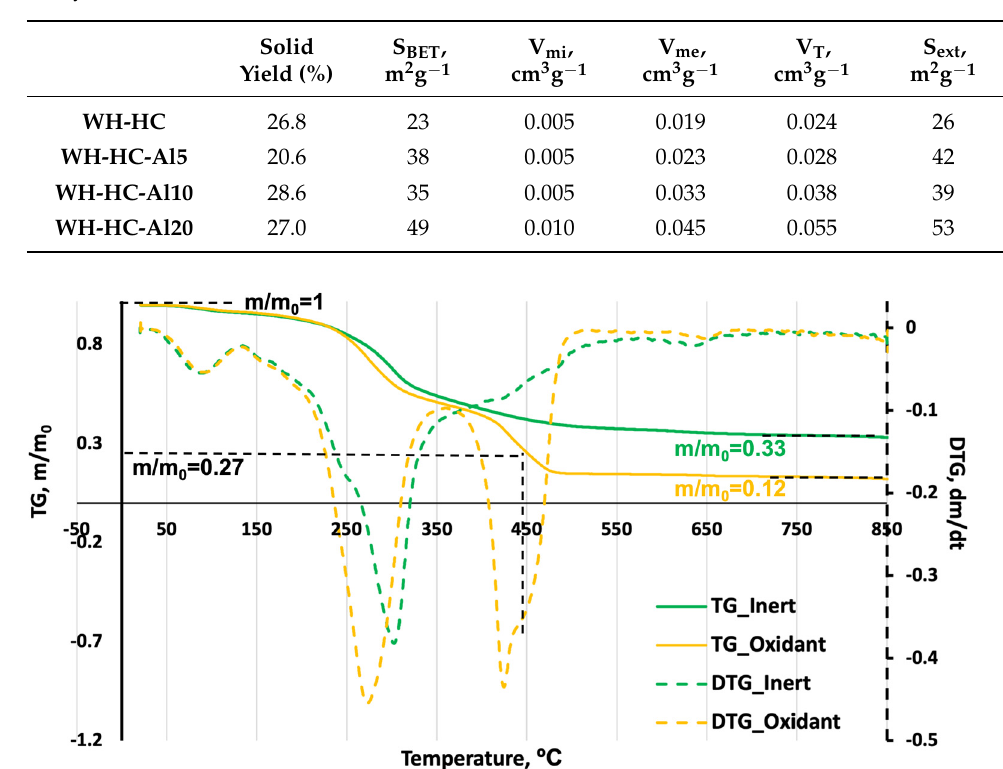
Table 1. Solid yield (SY, %) and N 2 adsorption textural parameters of uncatalyzed HC and Al- catalyzed HCs.